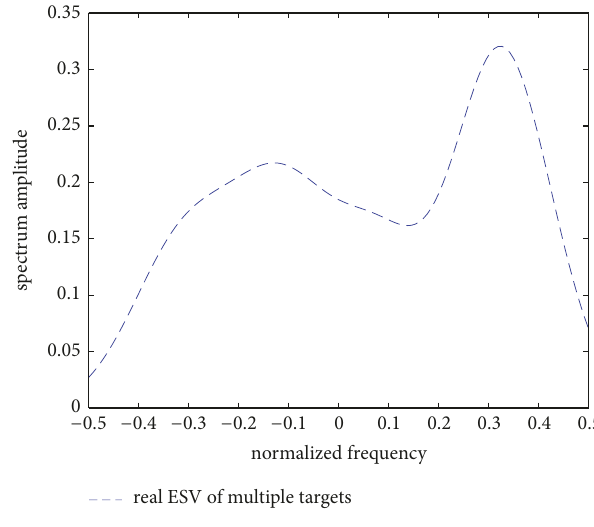
Figure 8: Nominal ESV for multiple targets.